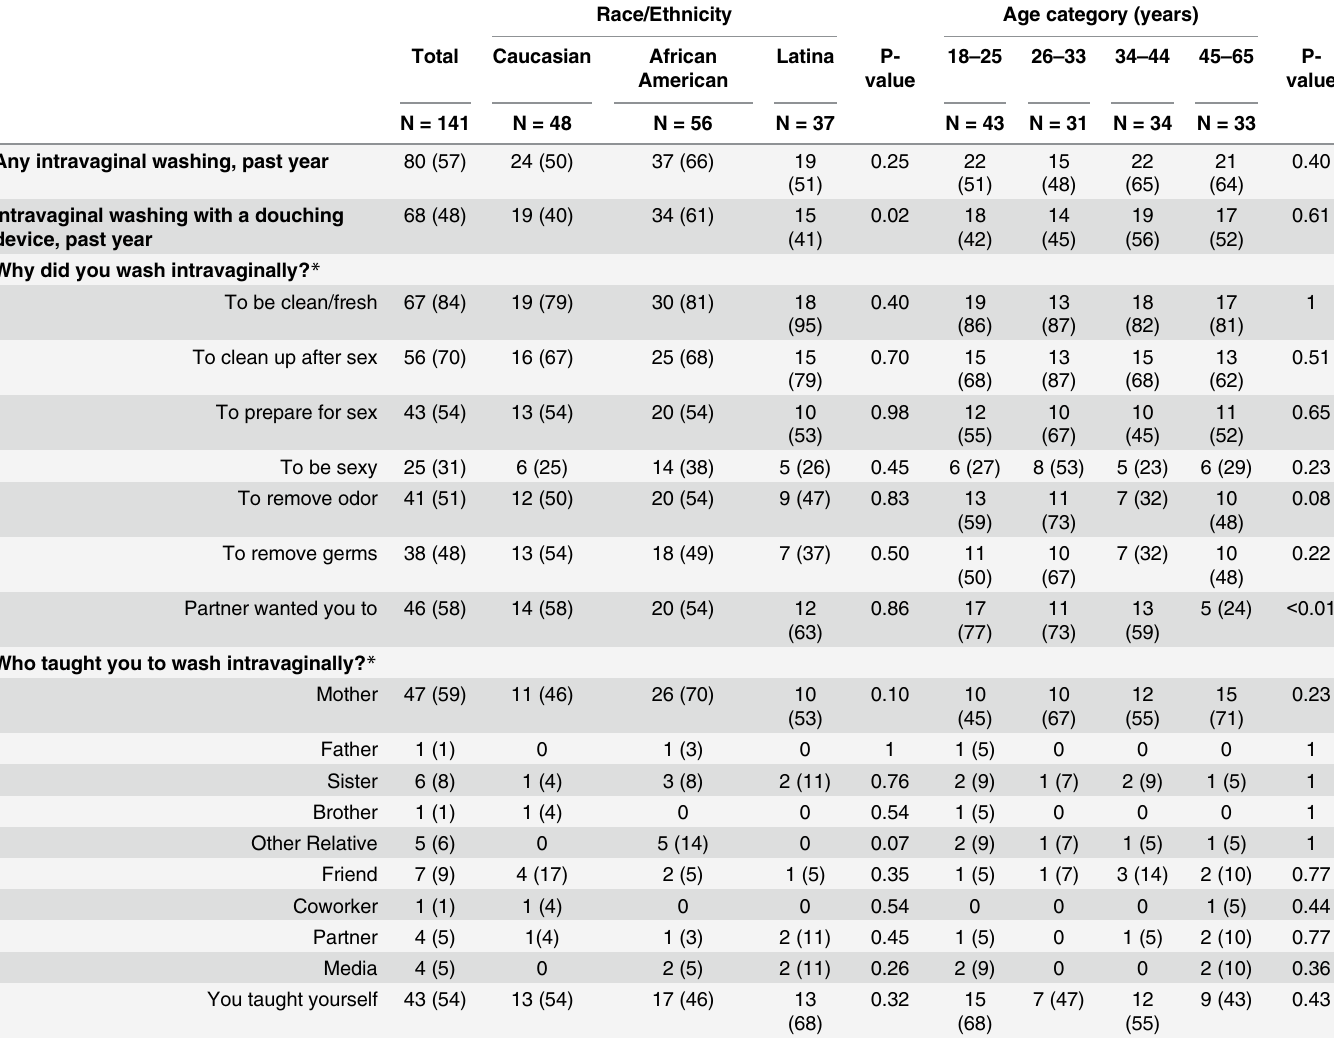
Table 2. Motivations for intravaginal washing over the past year by race/ethnicity and